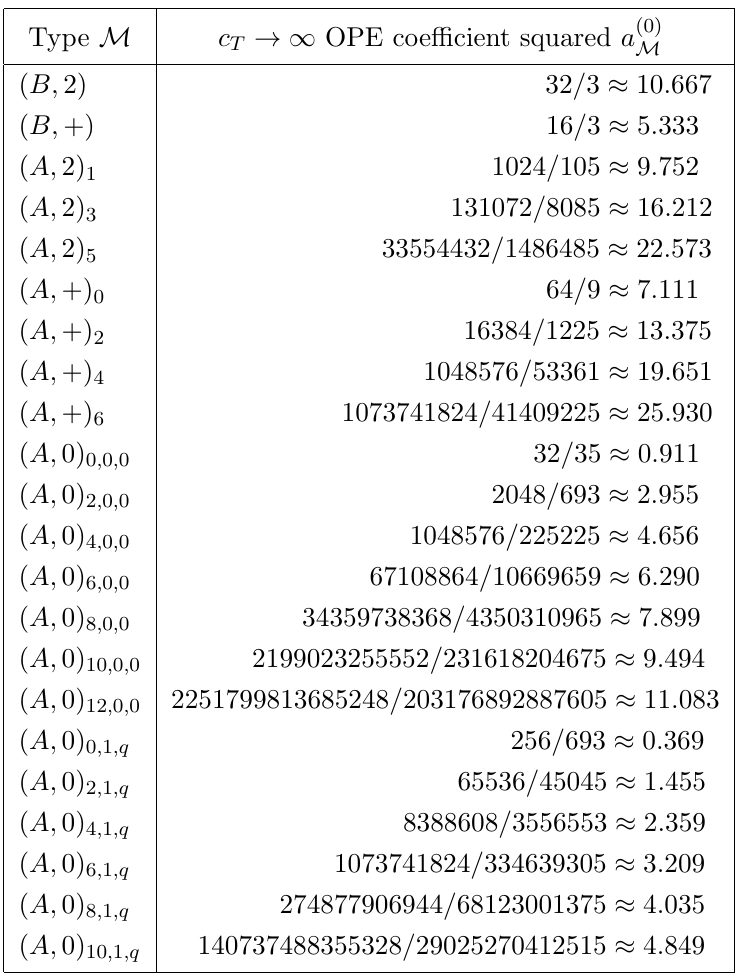
at c T ! 1 for low-lying multiplets M in M